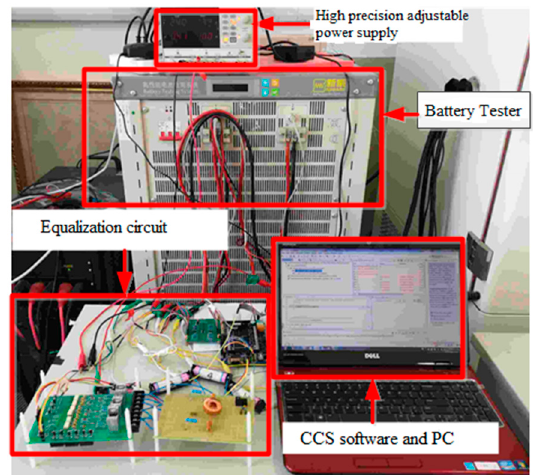
Figure 14. Active equilibrium system platform.